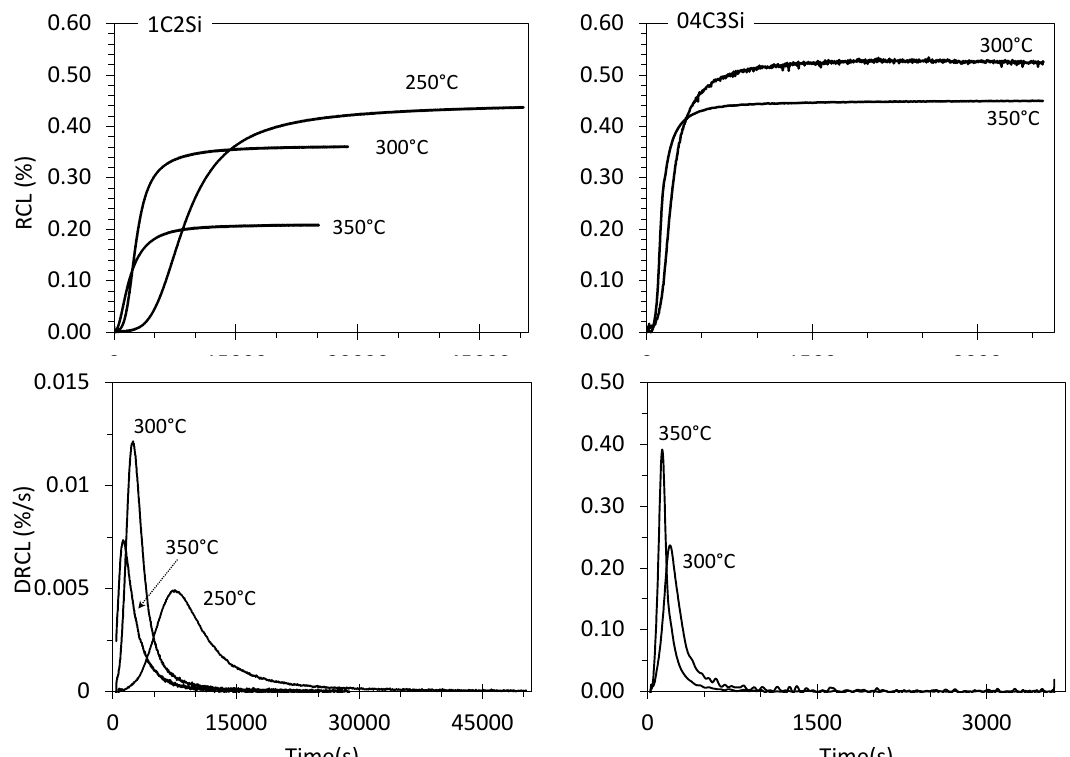
Figure 4. For both alloys, curves of the relative change in length (RCL) and its first derivative (DRCL) at different values of T Iso .